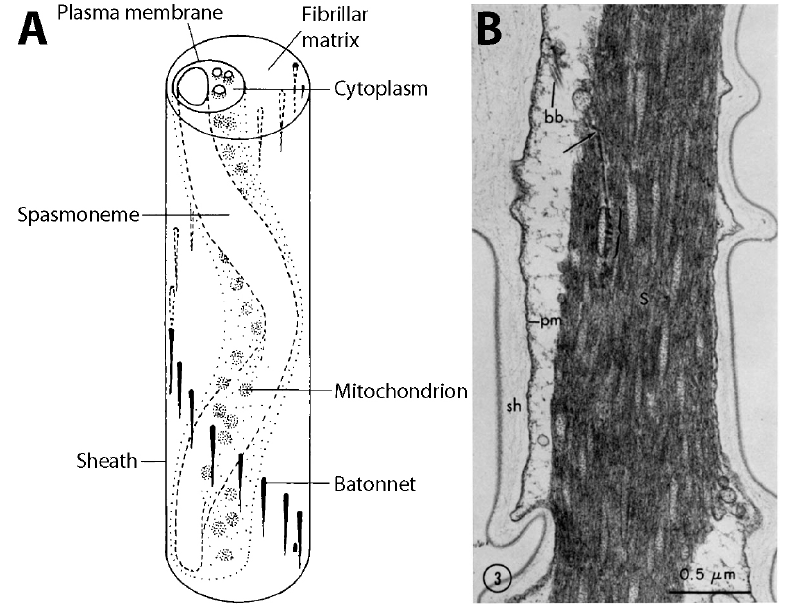
Figure 7. Structure of the Vorticella stalk. ( A ) Schematic of the stalk (reproduced from [37]); ( B ) cross-sectional micrograph of the stalk showing that the spasmoneme is composed of 3–4 nm-diameter fibrils (reproduced from [67]).